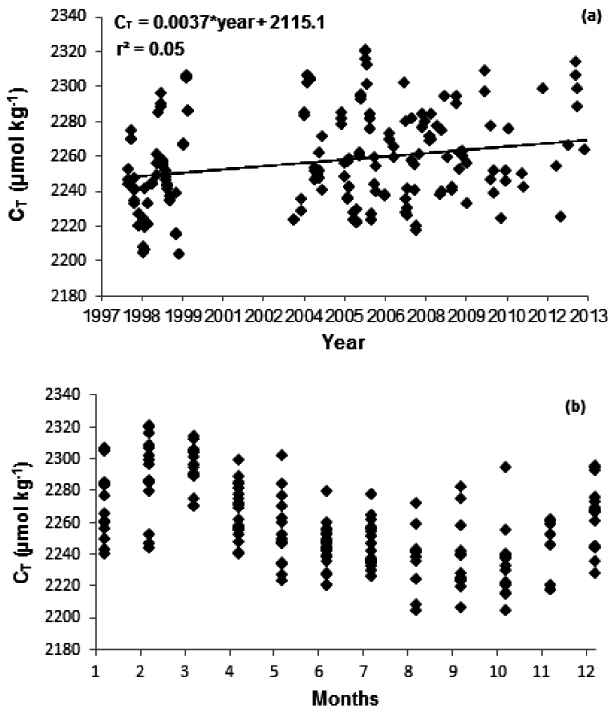
Figure 4. (a) Temporal and (b) seasonal variations of C T measured at the DYFAMED time-series station between 1998 and